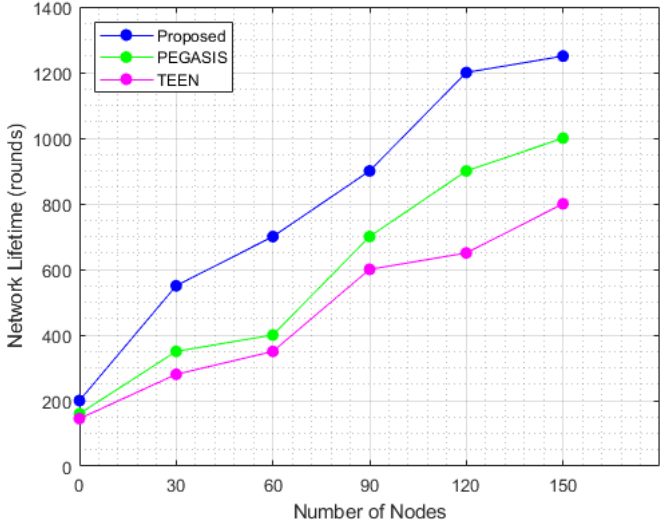
Figure 8. Number of nodes vs. network lifetime with 100 nodes.